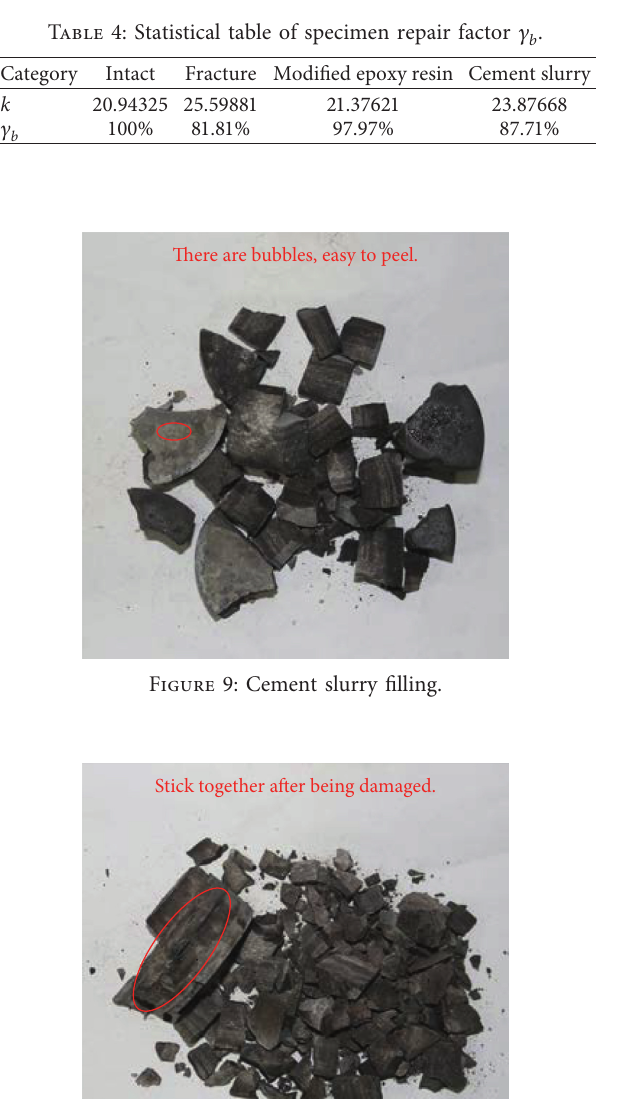
Table 4: Statistical table of specimen repair factor c